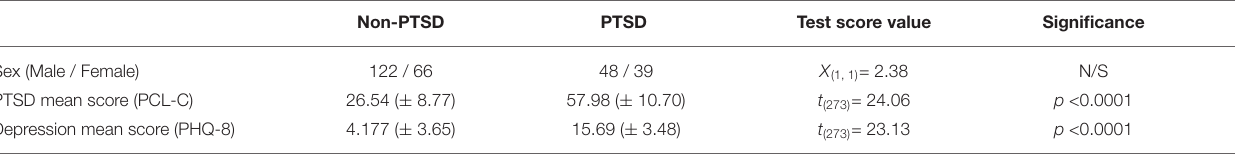
TABLE 1 | Demographics and outcome measures.